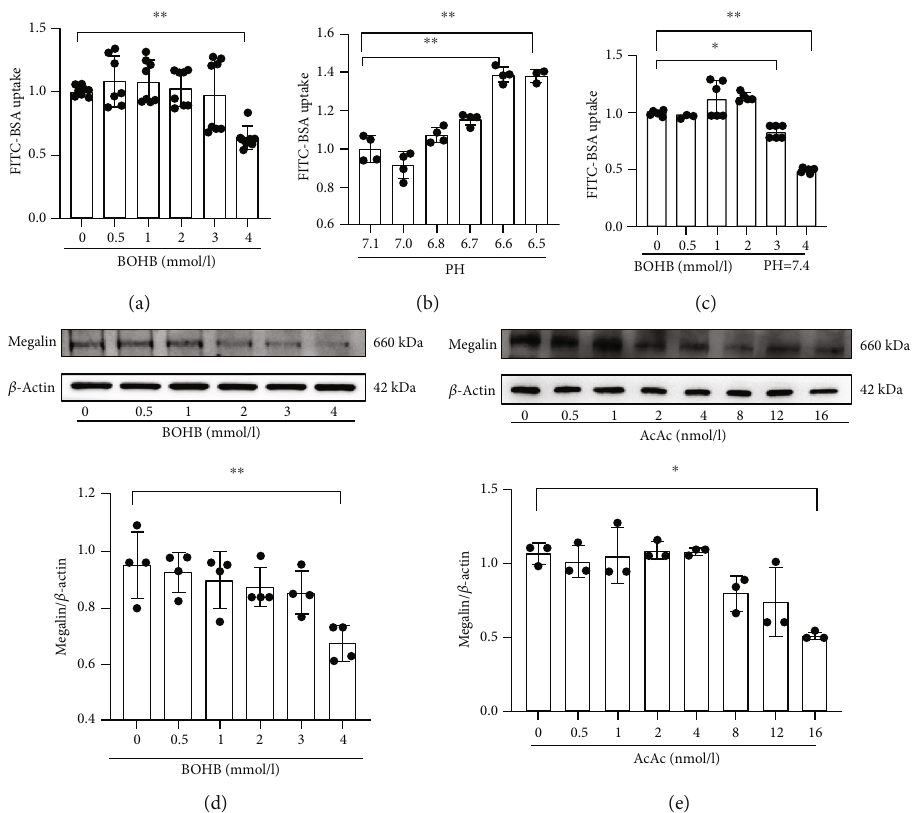
Figure 3: E ff ects of di ff erent concentrations of BOHB and acetoacetate on endocytosis and megalin expression of HK-2 cells. (a) Quanti fi cation of FITC-BSA uptake in HK2 cells in di ff erent concentrations of BOHB. (b) Quanti fi cation of FITC-BSA uptake in HK2 cells in the indicated pH level. pH 7.1 represents 0 mmol/l BOHB; pH 7.0 represents 0.5 mmol/l BOHB; pH 6.8 represents 1 mmol/l BOHB; pH 6.7 represents 2 mmol/l BOHB; pH 6.6 represents 3 mmol/l BOHB; pH 6.5 represents 4 mmol/l BOHB. (c) Quanti fi cation of FITC-BSA uptake in HK2 cells in di ff erent concentrations of BOHB when pH was adjusted to 7.4. (d) Representative western blotting images and quanti fi cation of megalin in di ff erent concentrations of BOHB. (E) Representative western blotting images and quanti fi cation of megalin in di ff erent concentrations of AcAc. AcAc, acetoacetate; BOHB, beta-hydroxybutyric acid. Data are expressed as mean ± SD . ∗∗ Represents P < 0 : 01 ; ∗ represents P < 0 : 05